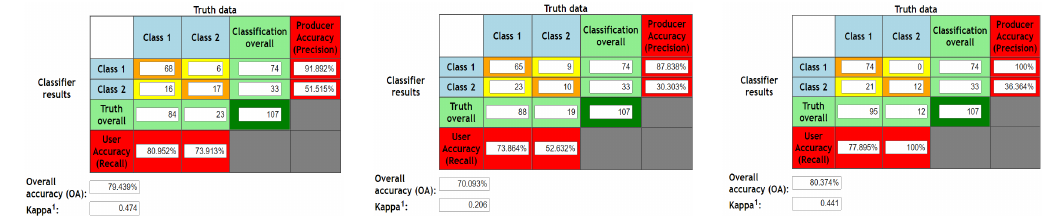
Figure 5. Confusion matrix for validation phase of 2D images for SVM, LSTM and VAE3CNN respectively.